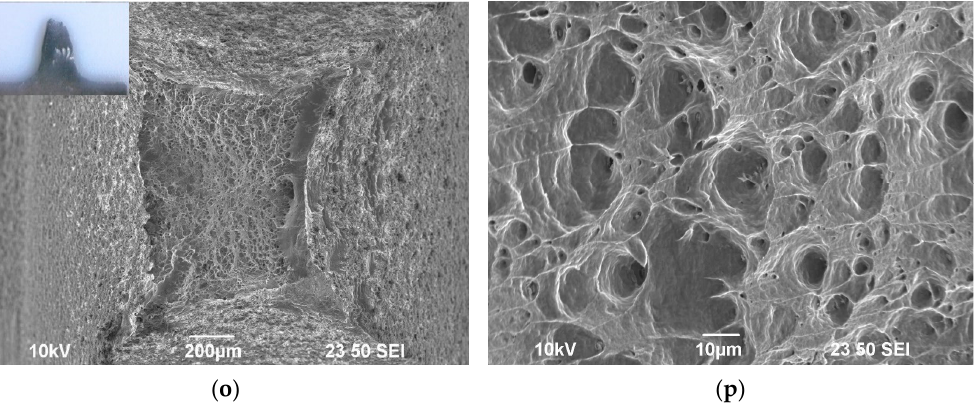
Figure A1. SEM images of the surface of fractures in alloy specimens No. 1 ( a , b ), 2 ( c , d ), 3 ( e , f ), 4 ( g , h ), 5 ( i , j ), 6 ( k , l ), 7 ( m , n ), and 8 ( o , p ) after tensile tests at room temperature. Appendix B shows the stress–strain curves for the UFG alloy specimens tested at elevated temperatures and at a strain rate of 3.3 × 10 − 3 s − 1 .